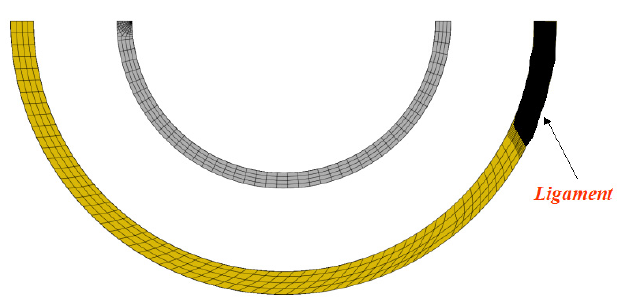
Figure 26: Detail of residual ligament in